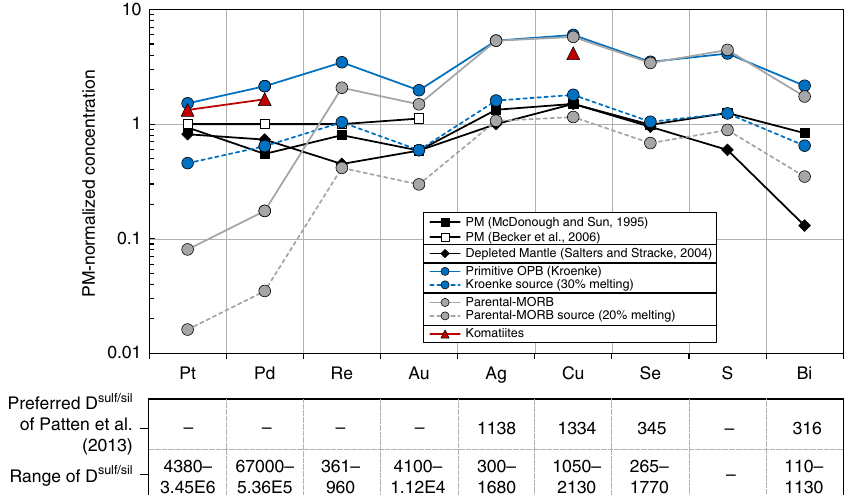
Fig. 7 Primitive mantle-normalized PGE and CSE abundances of primitive OPB, MORB and komatiites. The CSE patterns of primitive OPB (Kroenke; blue line) and parental-MORB (orange line) are similar for Ag, Cu, Se, S and Bi. Together with their chondritic S/Se, this suggests that sul fi de was exhausted from both the MORB-and OPB-source mantle and that melting terminated close to the point of sul fi de-exhaustion. By contrast, komatiites are offset to lower primitive mantle-normalized Pt, Pd and Cu. Given that komatiites are generated by signi fi cantly high degrees of partial melting 54 , these offsets suggest that the [CSE] of komatiites were diluted by continued melting in the absence of residual sul fi de. Assuming that the CSE behaved perfectly incompatible after sul fi de-exhaustion, estimates of the mantle source composition of OPB and MORB (dashed lines) are derived by assuming 30% and 20% degree of melting, respectively. The OPB mantle source estimate is well-matched to the primitive mantle estimates of McDonough and Sun 15 , supporting our interpretation that sul fi de was exhausted from the OPB mantle source. PGE data for OPB and MORB are taken from Chazey and Neal 31 and the compilation of Barnes et al. 46 , respectively. Parental-MORB CSE estimates are taken from Jenner 1 , except for Se, which is calculated from new MORB data presented in this study. PGE and Cu data for komatiites is taken from Puchtel and Humayan 54 . Sul fi de-silicate partition coef fi cients are taken from Mungall and Brenan 53 (Pt, Pd and Au) and Patten et al. 6 (Re, Ag, Cu, Se and Bi). Data are normalized to the primitive mantle estimates of Palme